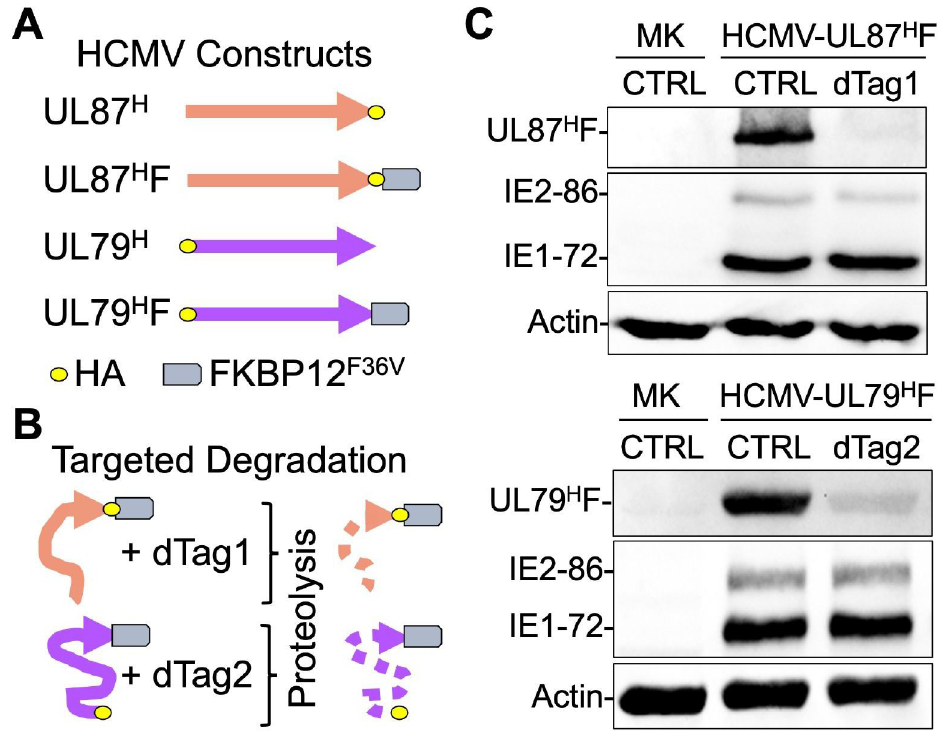
Fig 1. Rapid depletion of UL79 and UL87 LTFs in late infection. ( A ) The carboxy and amino ends of UL87 and UL79 LTFs (orange and violet arrows) of HCMV Towne and TB40/E strains, respectively, were tagged with the HA epitope. Fusing the FKBP12 F36V tag to the carboxy ends of these LTFs created HCMV UL87 H F and UL79 H F constructs, whereas the comparator HCMV UL87 H and UL79 H constructs lack FKBP12 F36V . ( B ) dTag1 and dTag2 degraders were added for 6 h at the end of HCMV UL87 H F and UL79 H F infections (MOI of 3), respectively, to deplete FKBP12 F36V -tagged LTFs via proteolysis. ( C ) Western blot reveals that dTag treatments result in 94% and 87% depletion of UL87 H F and UL79 H F, respectively, at 96 and 72 h pi. Viral IE1-72 and IE2-86 protein levels did not change.